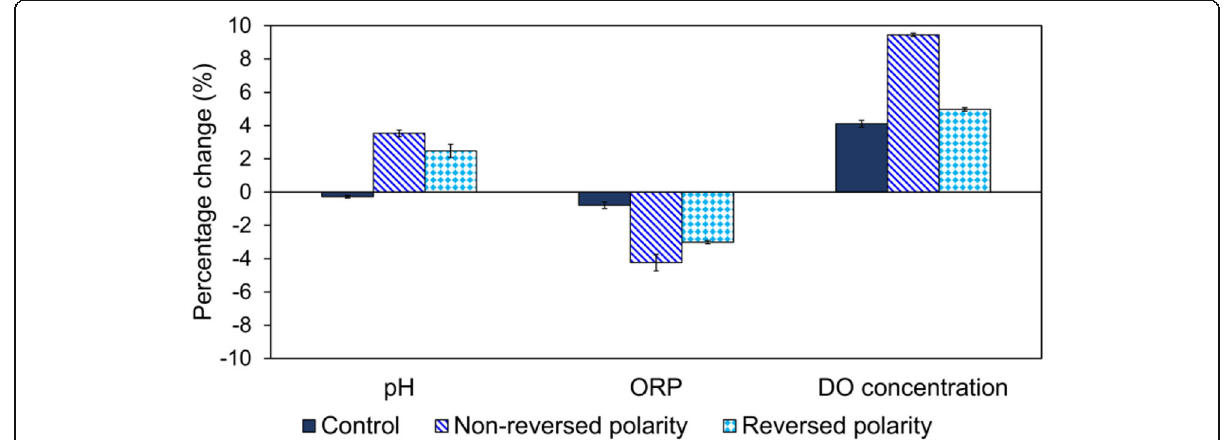
Fig. 3 Results of pH, ORP and DO concentration of water after magnetization by using different magnets